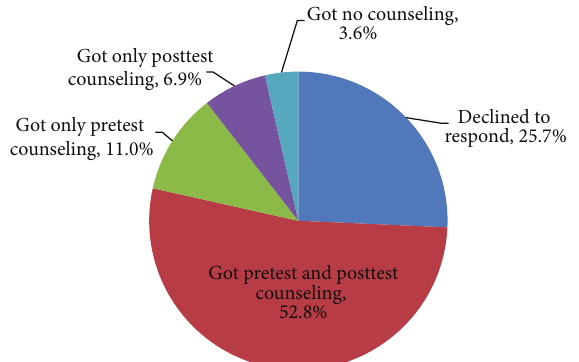
Figure 2: Counseling among those who had undertaken HIV test prior to the study.